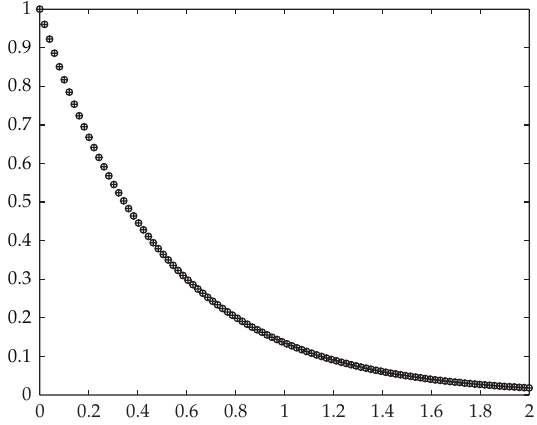
Figure 4: Index 2, T (cid:8) 2, the y 2 -coordinate, “o”-original, “ (cid:9)